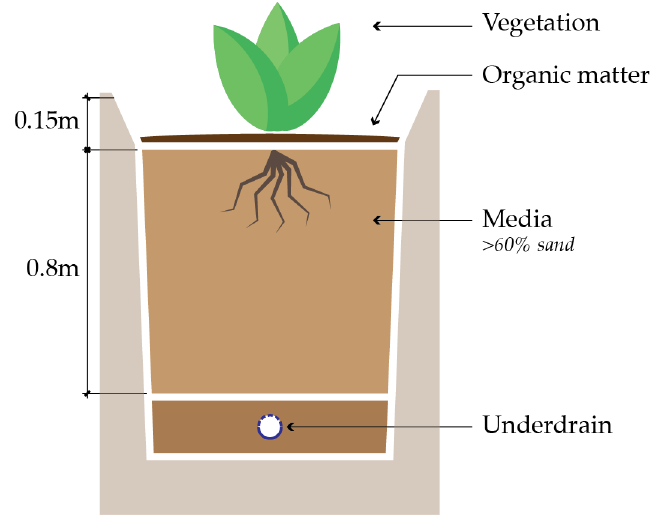
Figure 5. Typical bioretention cell, according to average features reported in the literature. Media depth and ponding depth represent the average of reported values, and the percentage sand in the media represents the range of reported values.